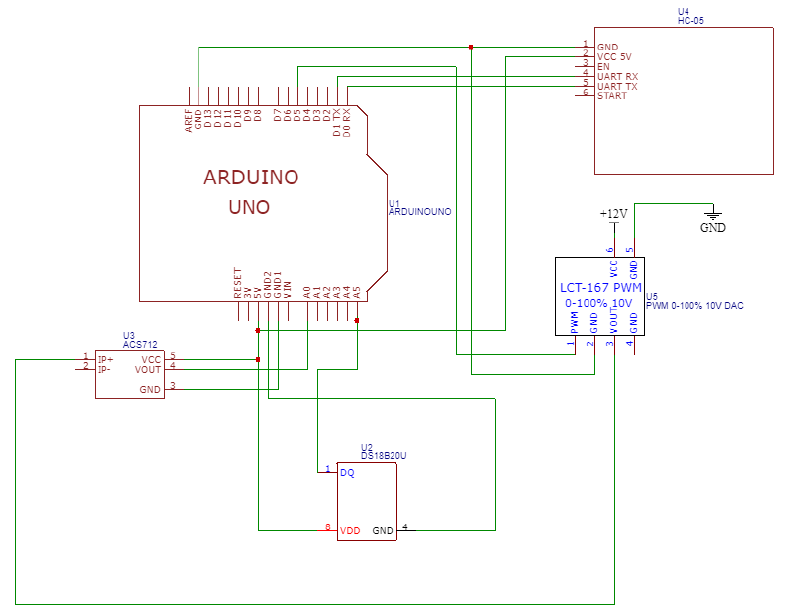
Figure 2. Schematic diagram of the control system using a Bluetooth transmission module.